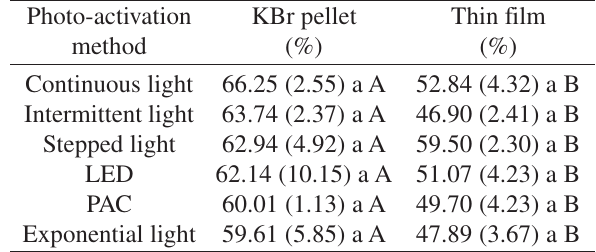
Table 3. Means of DC according to FTIR technique analyzed and photo-activation methods used (24